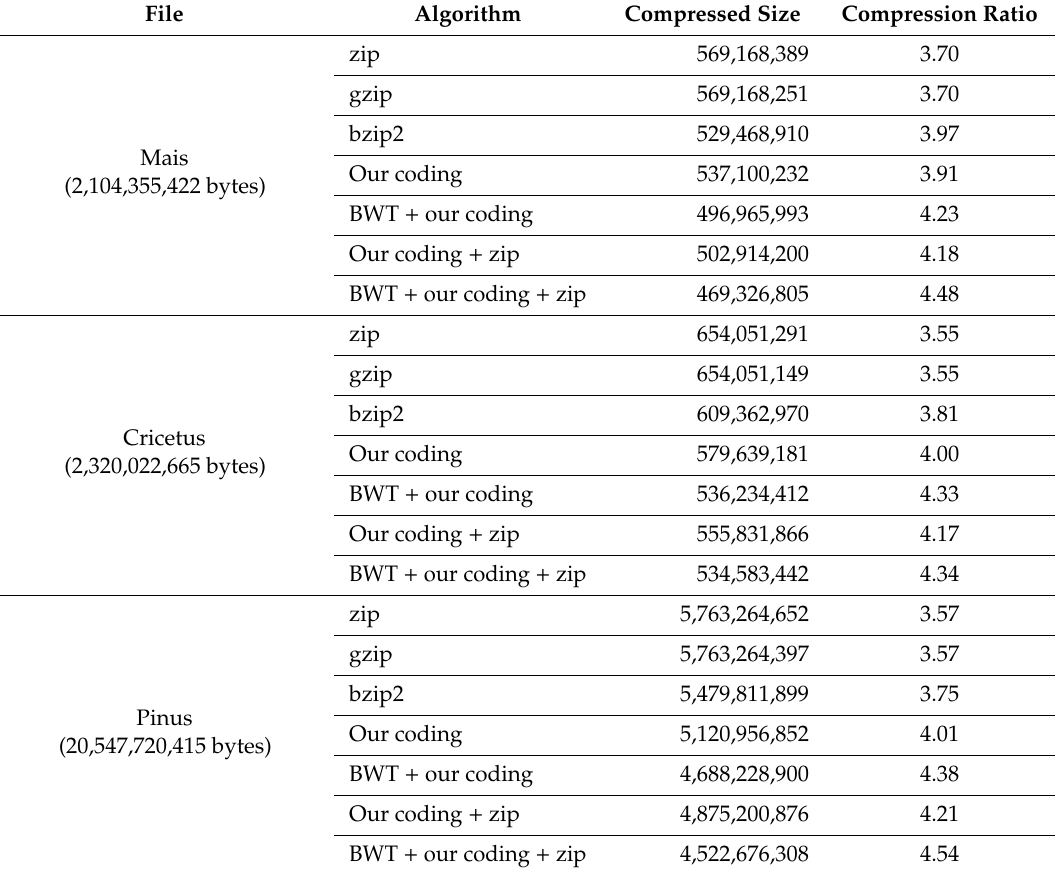
Table 3. Experimental results